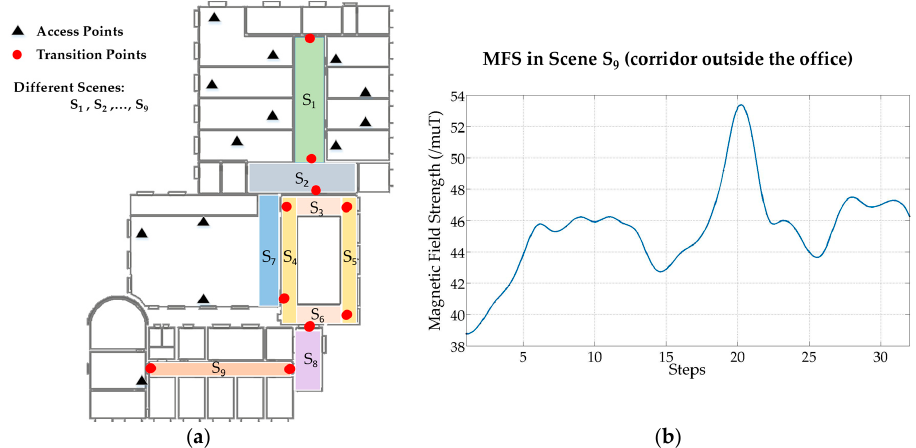
Figure 5. Environment information on the third floor of laboratory. ( a ) There are 13 access points, ten transition points and nine different scenes on this floor; ( b ) Change of MFS when walking in scene S 9 .